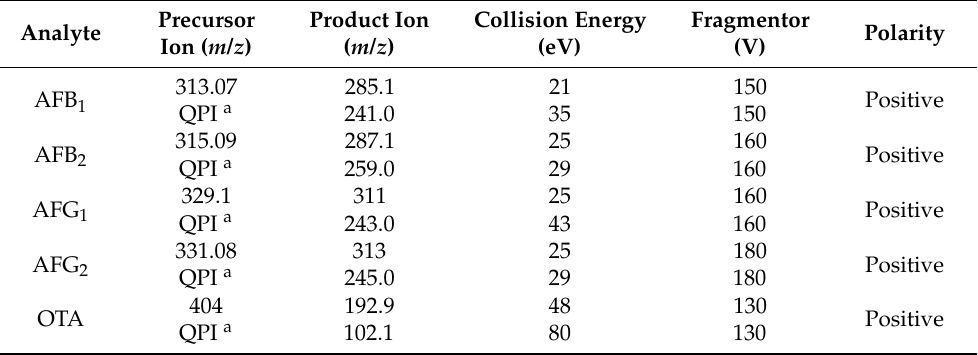
Table 1. MS/MS parameter for determination of nine